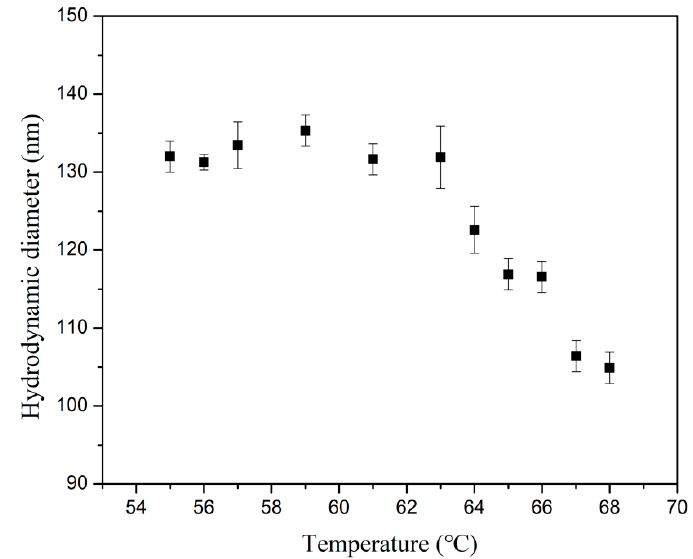
Figure 5. Hydrodynamic diameter of SiO 2 - g -POEGMA nanoparticle as a function of temperature. The error bars correspond to standard deviations from three measurements.